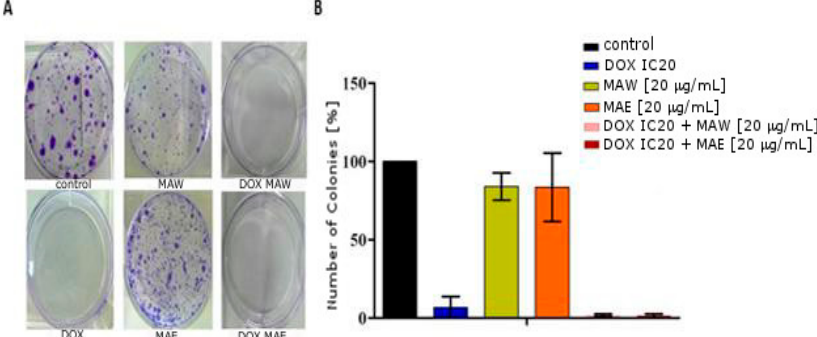
Figure 3. E ff ects of M. aquifolium extracts and DOX on A549 colony forming ability. ( A ) Representative Figure 3. Effects of M. aquifolium extracts and DOX on A549 colony forming ability. ( A ) images of colonies stained with Coomassie Brilliant Blue following treatment with DOX IC20, MAW (20 µ g / mL), MAE (20 µ g / mL), or their combinations. Experiments were performed at least three times. ( B ) Quantitative analysis of results presented in